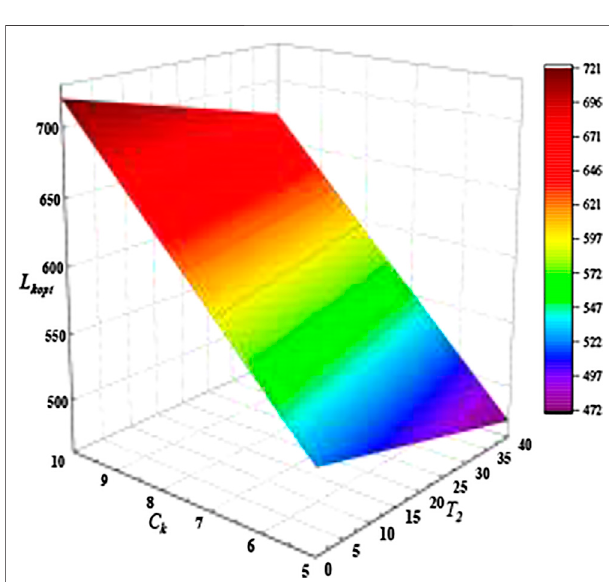
FIGURE 6 | Real estate business ’ s optimal pro fi t and carbon allowance, internal carbon price.